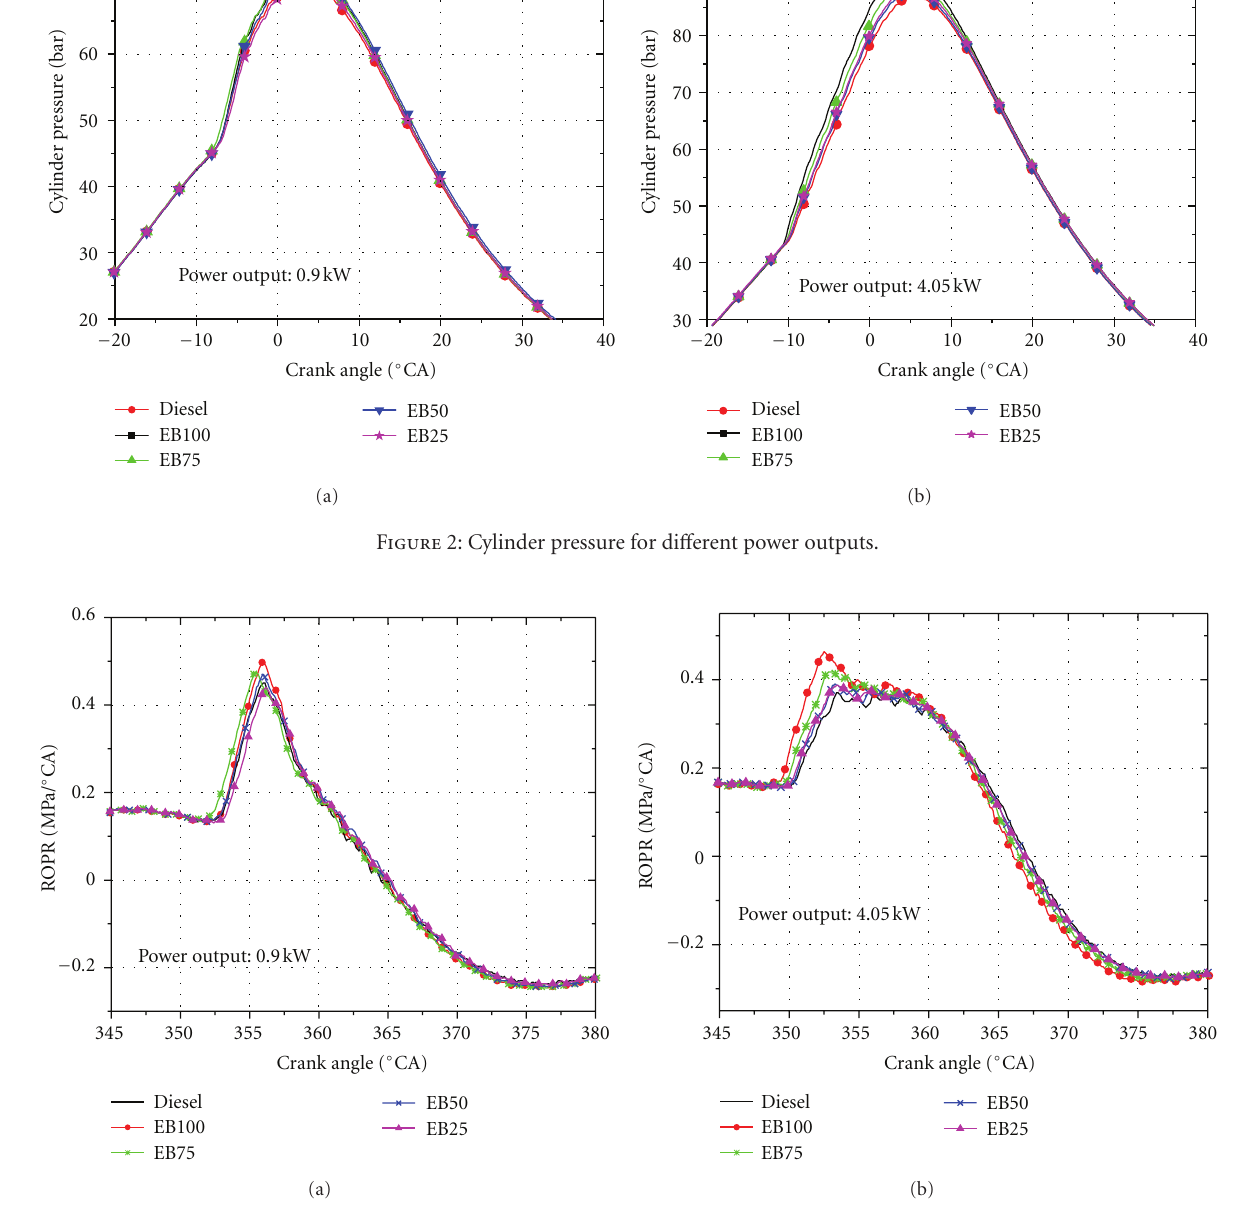
Figure 3: The rate of pressure rise (ROPR) at various power